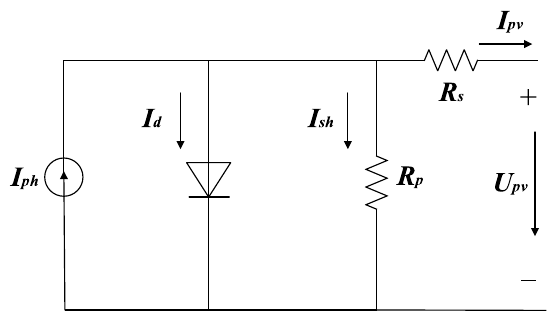
Fig. 1 The single-diode model of solar cells